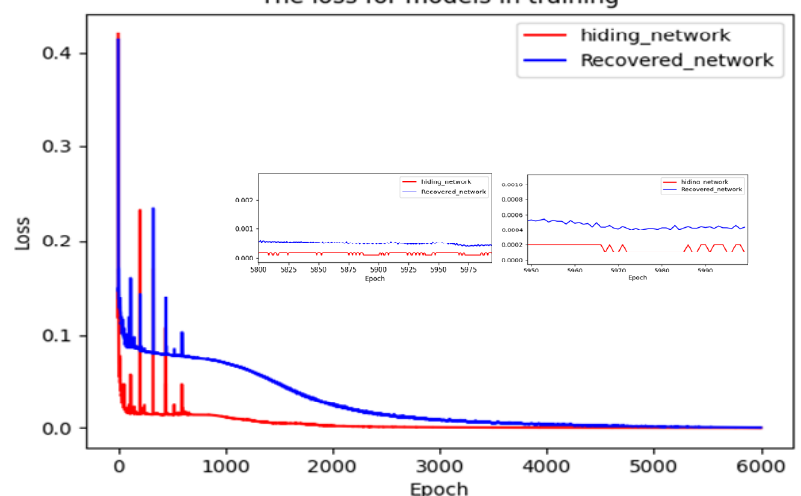
Figure 5. Loss function curves of hiding and recovery networks.